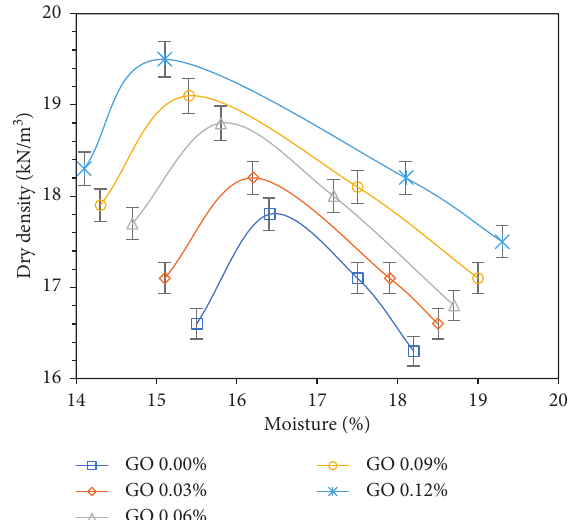
Figure 6: Curves of compactability of cemented loess changing with GO incorporation.